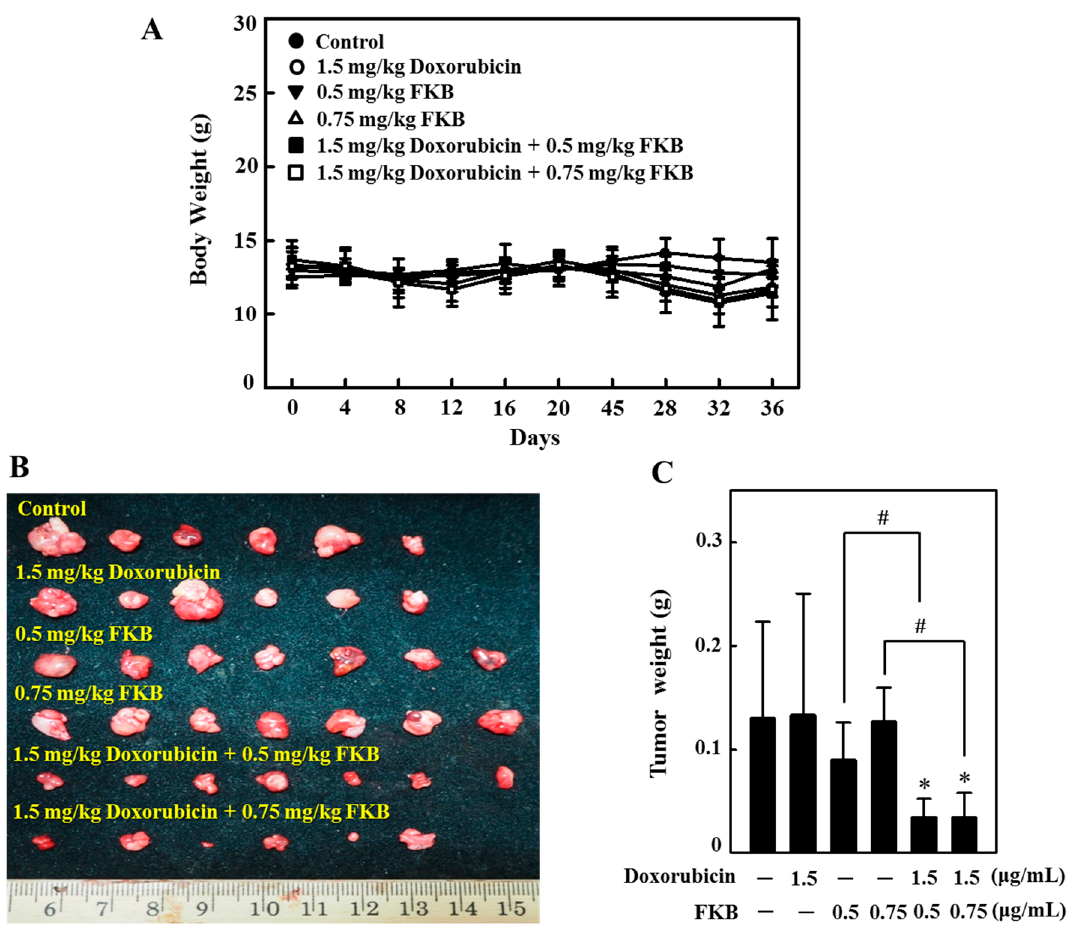
Figure 12. In vivo inhibition by co-treatment with FKB and doxorubicin of AGS-xenografted tumors in nude mice. BALB / c nude mice were intraperitonially injected with a vehicle (control) or doxorubicin (1.5 mg / kg, every two days) or FKB (0.5 mg or 0.75 mg / kg, every two days) or a combination of FKB and doxorubicin as indicated. ( A ) Body weight was measured 36 days every four days. ( B , C ) At the end of the 36th day animals were sacrificed, tumor tissues were removed, and weighed. Data were expressed as mean ± SD ( n = 3). Significant at * p < 0.05 compared to untreated control cells. Significant at # p < 0.05 compared to FKB-treated cells.